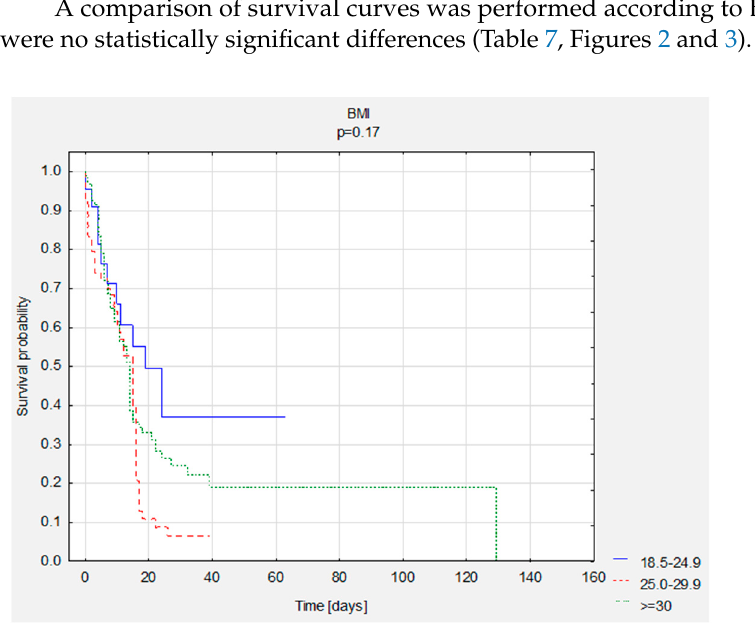
Figure 2. Comparison of survival curves according to BMI scores.